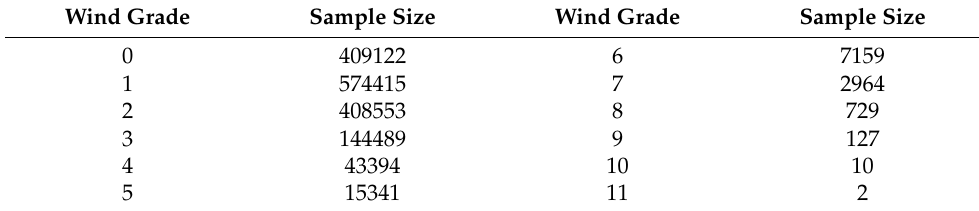
Table 4. Sample size of each wind grade from April to October